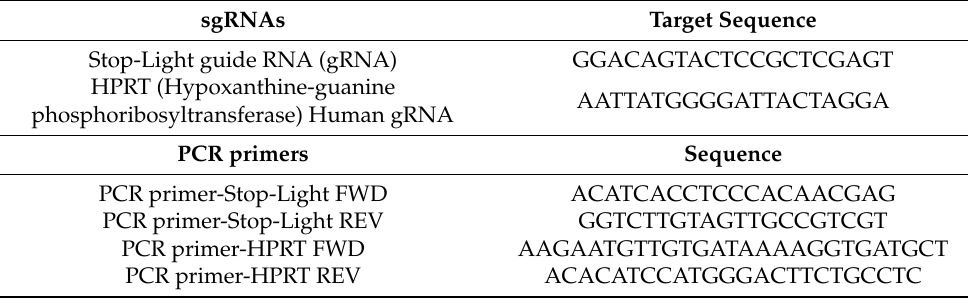
Table 2. Antibodies used, fluorescent tags, and relevant physio-chemical information. Target Tag Tag Weight (kDa) Tag Isoelectric Point